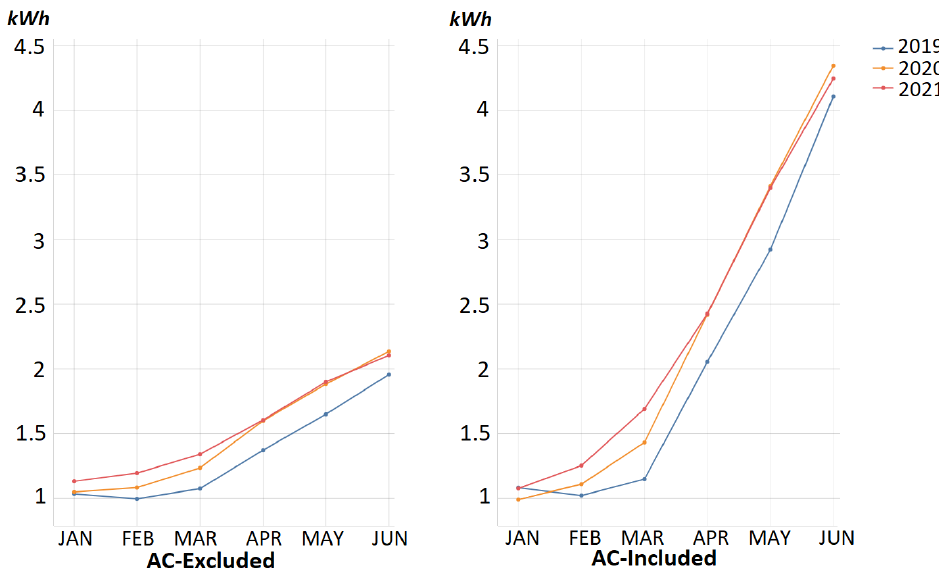
Figure 6. Consumption per user on monthly billing cycle for two AC categories.